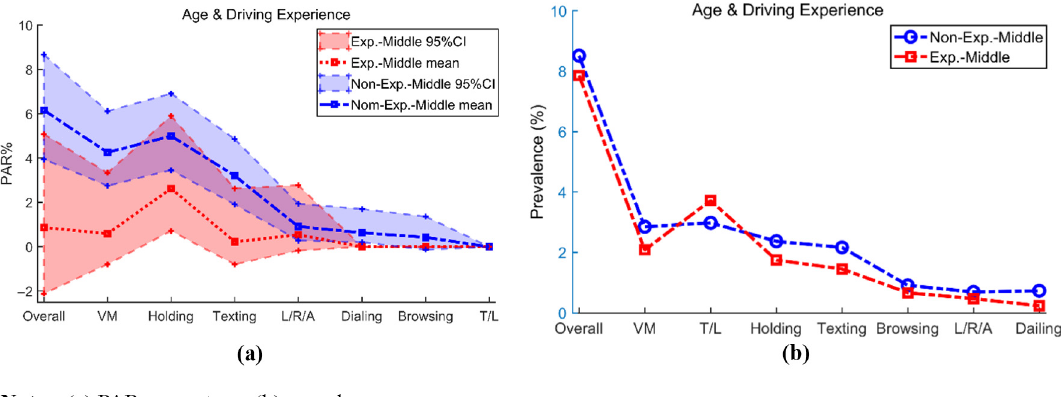
Figure 3 PAR percentage and prevalence analysis results of the combination of age and driving